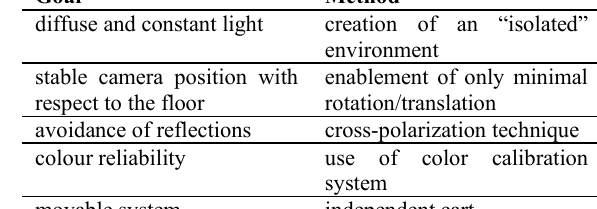
Table 1 : goals for the prototype and proposed solution